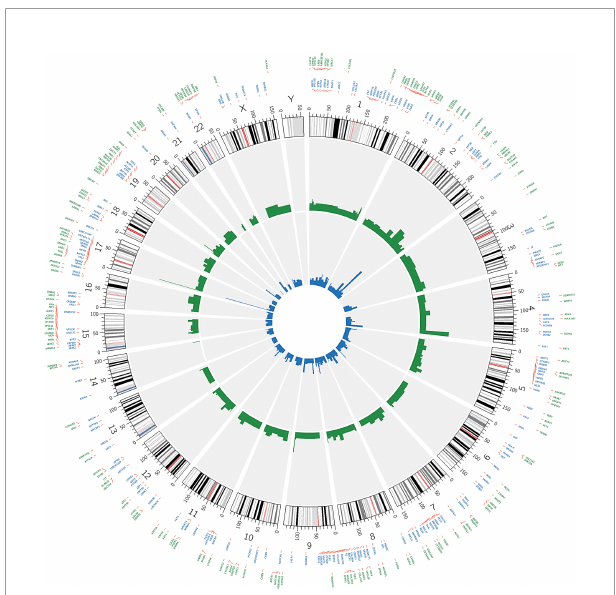
FIGURE 4 | Circos plot showing the 200 most frequently mutated genes in OSCC patients. The inner circle visualizes the mutation frequency of genes in the TCGA OSCC dataset. The outer cycle illustrates the genomic pro fi le which was observed in our